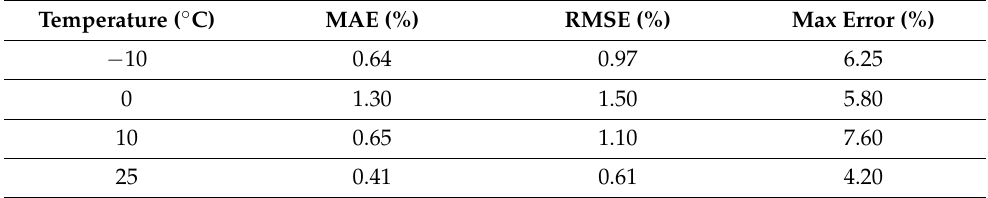
Table 7. The test result when the CNN-GRU-LSTM model is trained using separate temperature data.